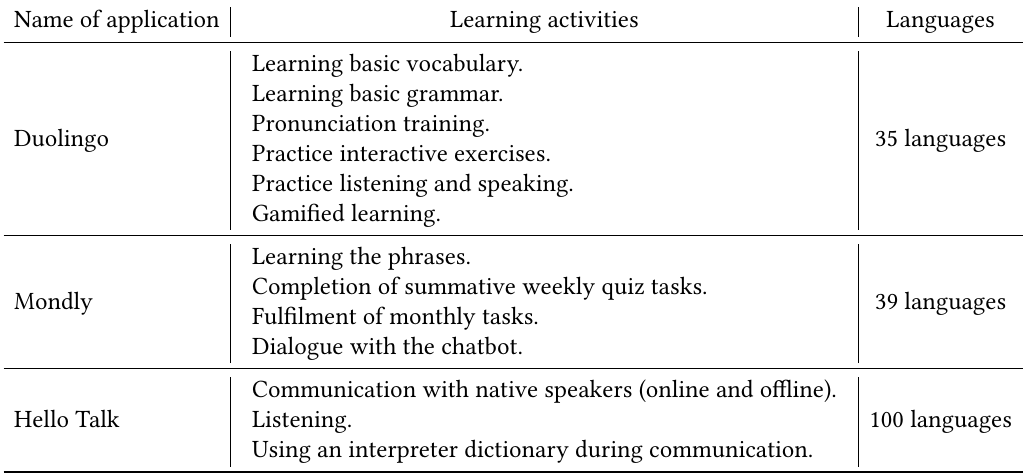
Table 2 Comparison of selected mobile language learning applications (free basic version /